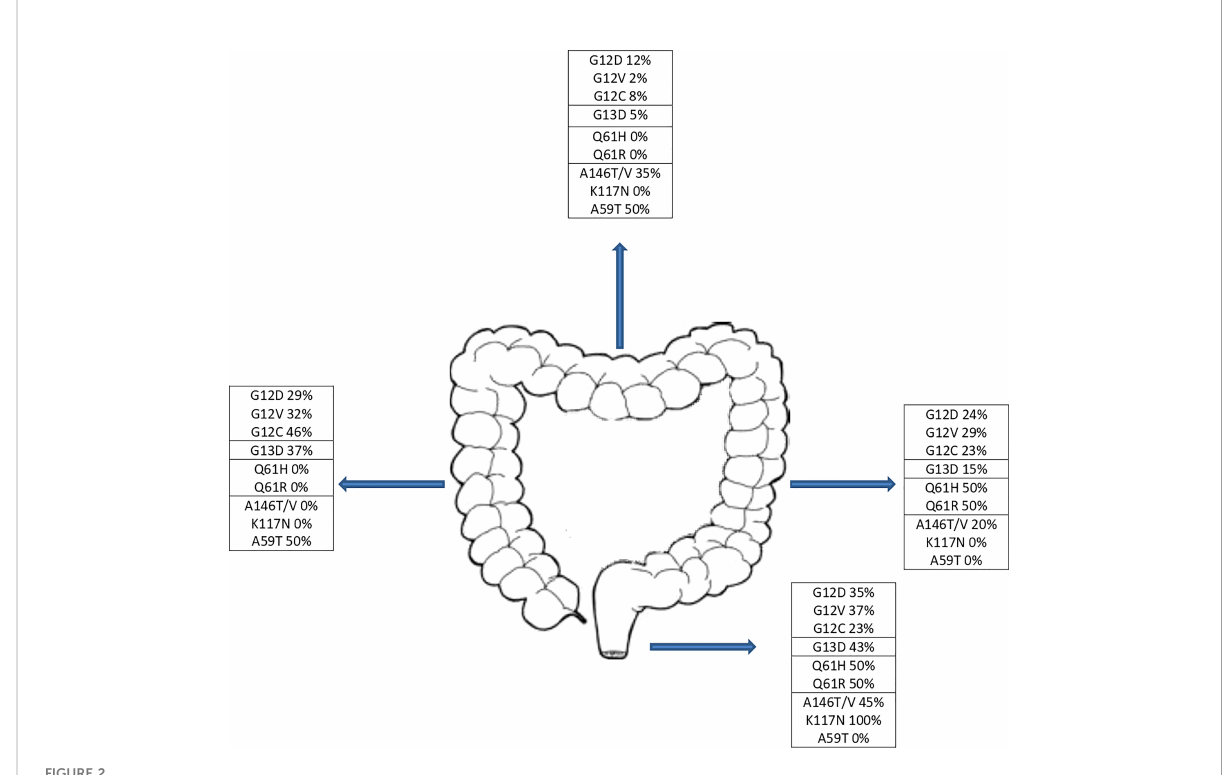
FIGURE 2 Distribution of KRAS mutations by tumor